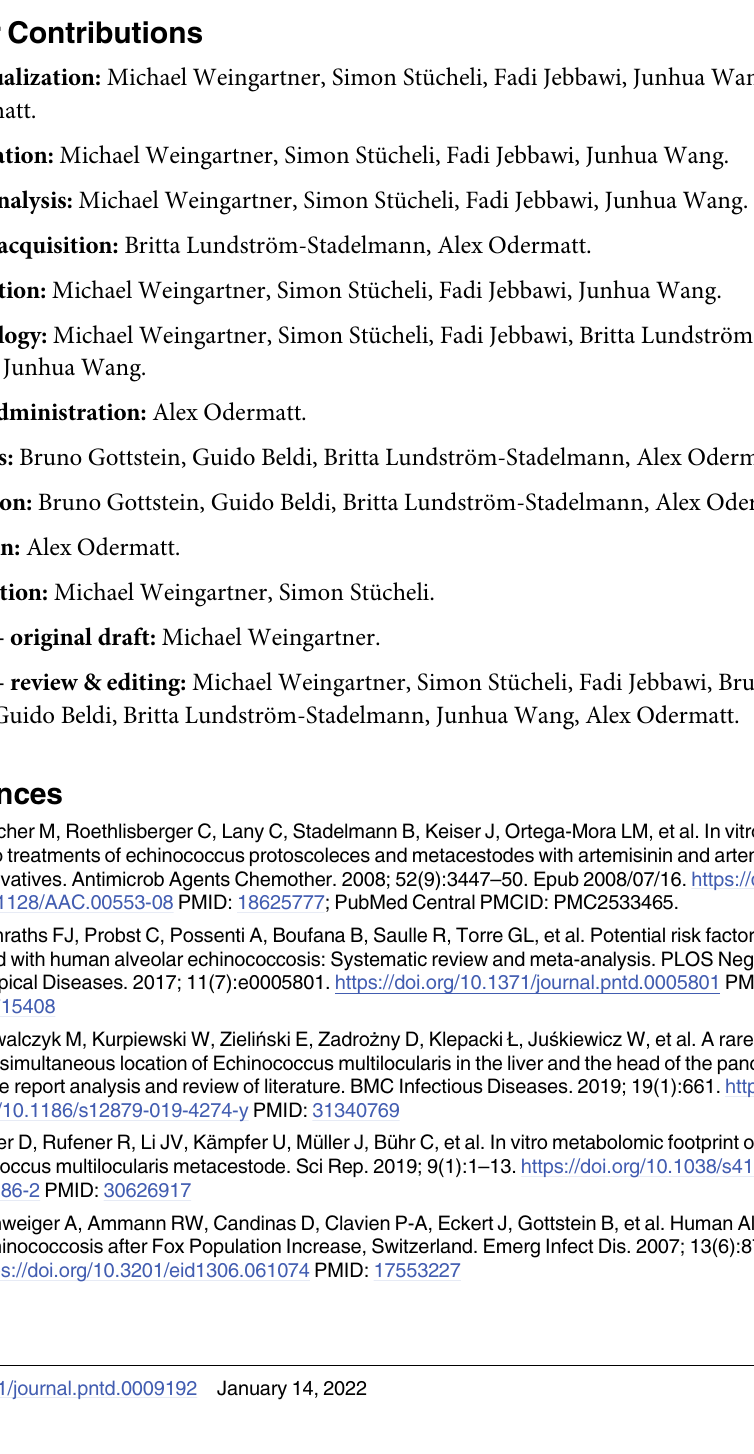
) and E . multi- n = 6